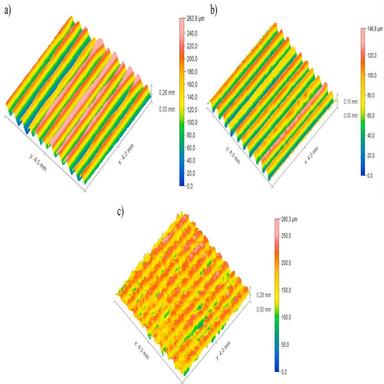
Surface height colour maps obtained from XCT reconstructions. a) FDM, b) Polyjet, c) SLS.